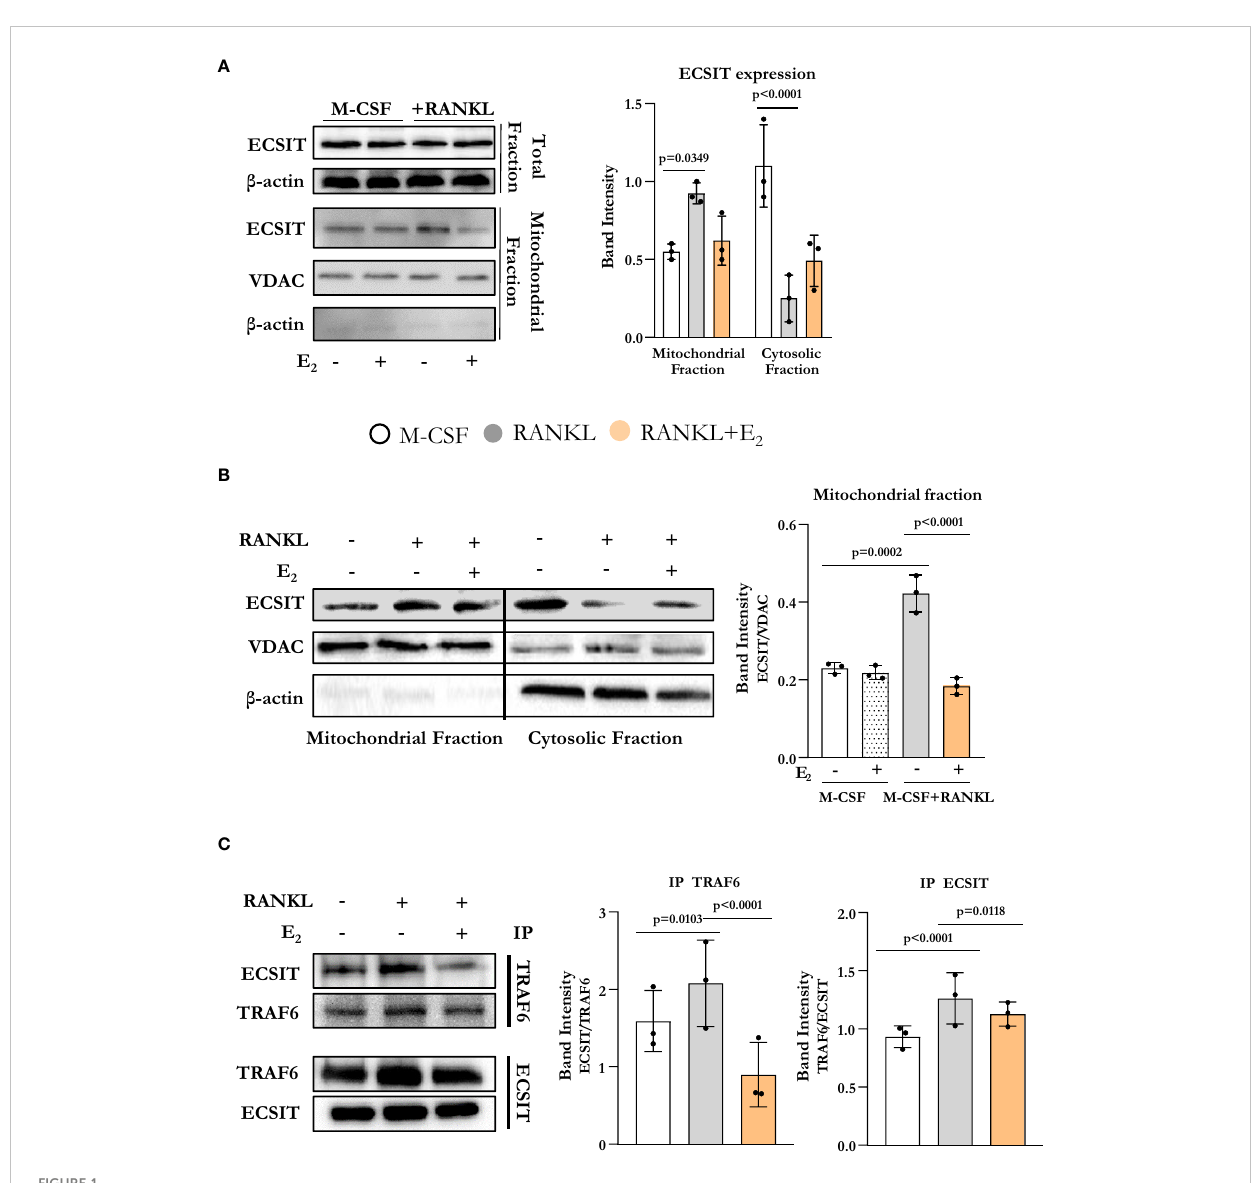
FIGURE 1 E 2 inhibits ECSIT translocation to mitochondria promoted by RANKL. (A – C) Representative protein levels by Western blot (left) and relative quanti fi cation of the bands from lysates of BMMs cultured with M-CSF and RANKL and with or without E 2 for 6 hours. (A, B) VDAC expression was used to normalize ECSIT protein in the mitochondria-enriched fractions, and b -actin was used to normalize ECSIT protein levels in the total or cytosolic fractions. (C) Immunoprecipitation (IP) of ECSIT with TRAF6 or TRAF6 with ECSIT in total cell lysates (right). Quanti fi cation of expression levels of ECSIT relative to TRAF6 (IP TRAF6) and expression levels of TRAF6 relative to ECSIT (IP ECSIT). Bar graphs depict mean ± S.D. of 3 separate experiments; p values by one-way